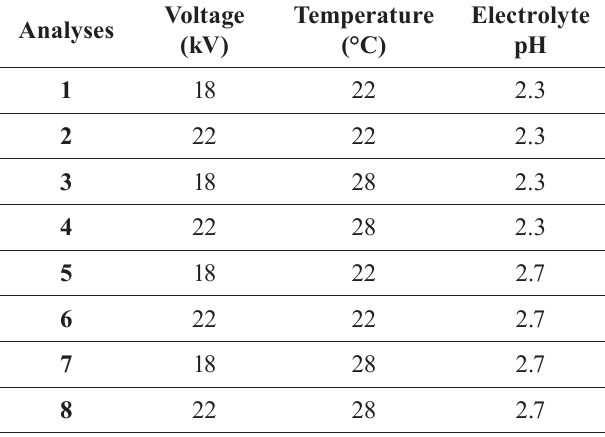
TABLE II - Variables applied for testing of robustness